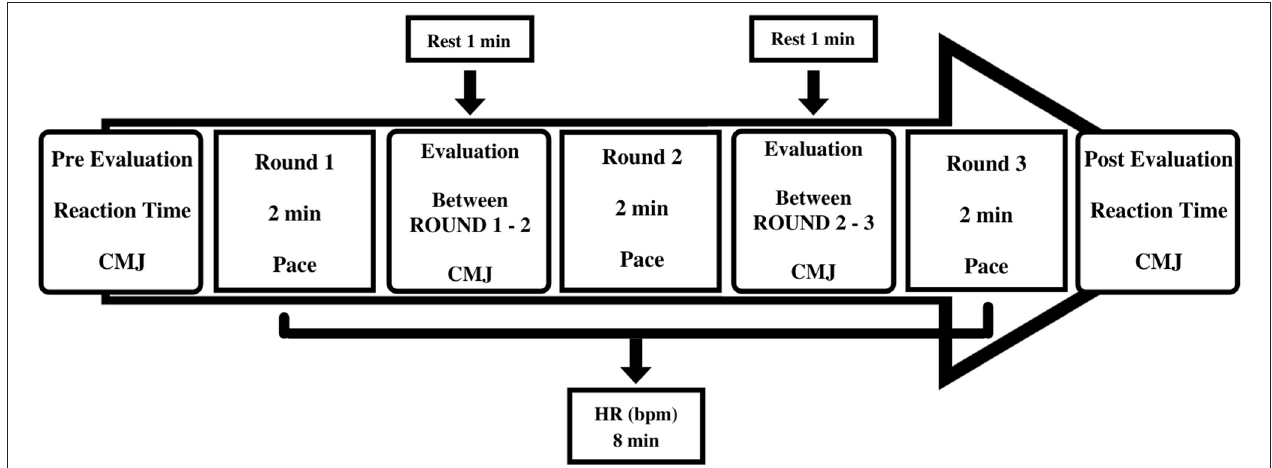
FIGURE 1 | Experimental design of evaluation protocol before, during, and after pace training